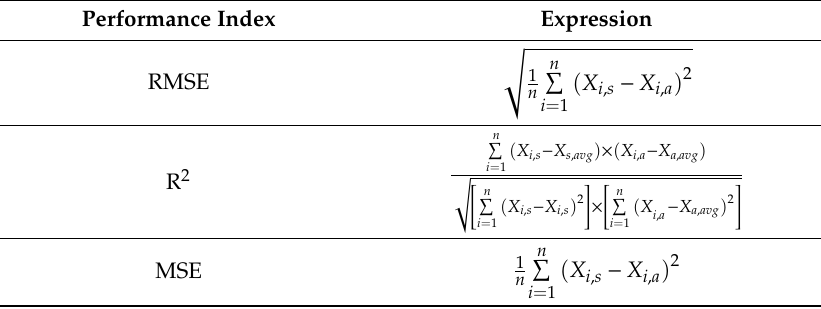
Table 3. Statistical performance indices.